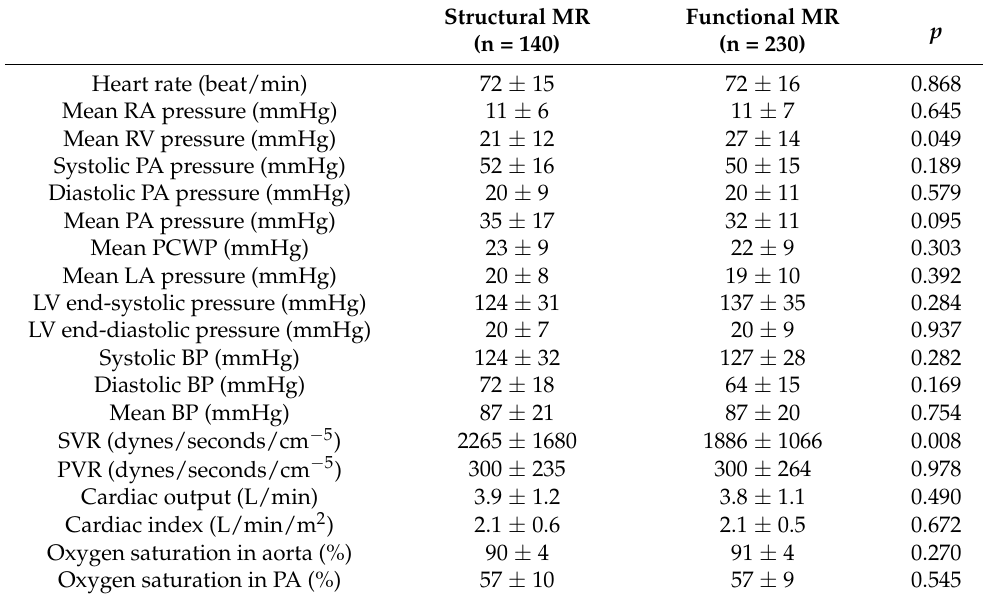
Table 2. Hemodynamic measurements in study